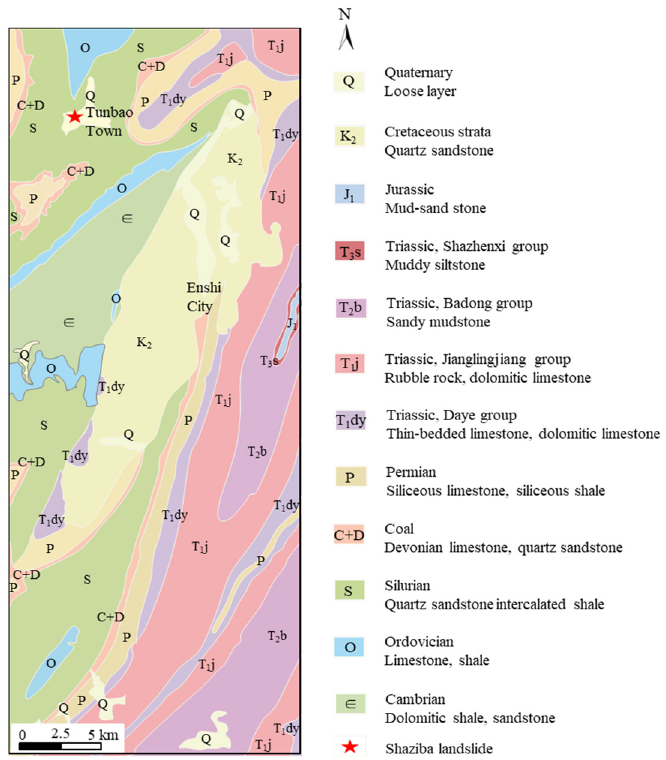
Figure 3. The geological map of the study